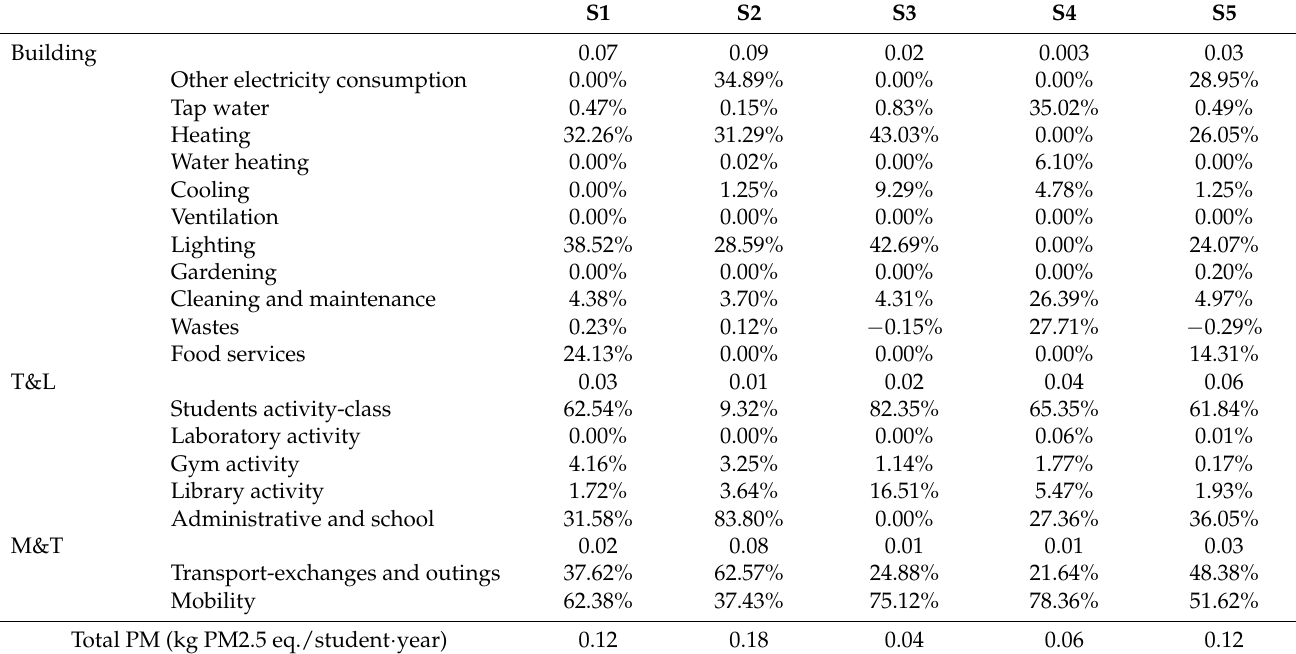
Table 8. Particulate matter impacts results per school, subsystem and